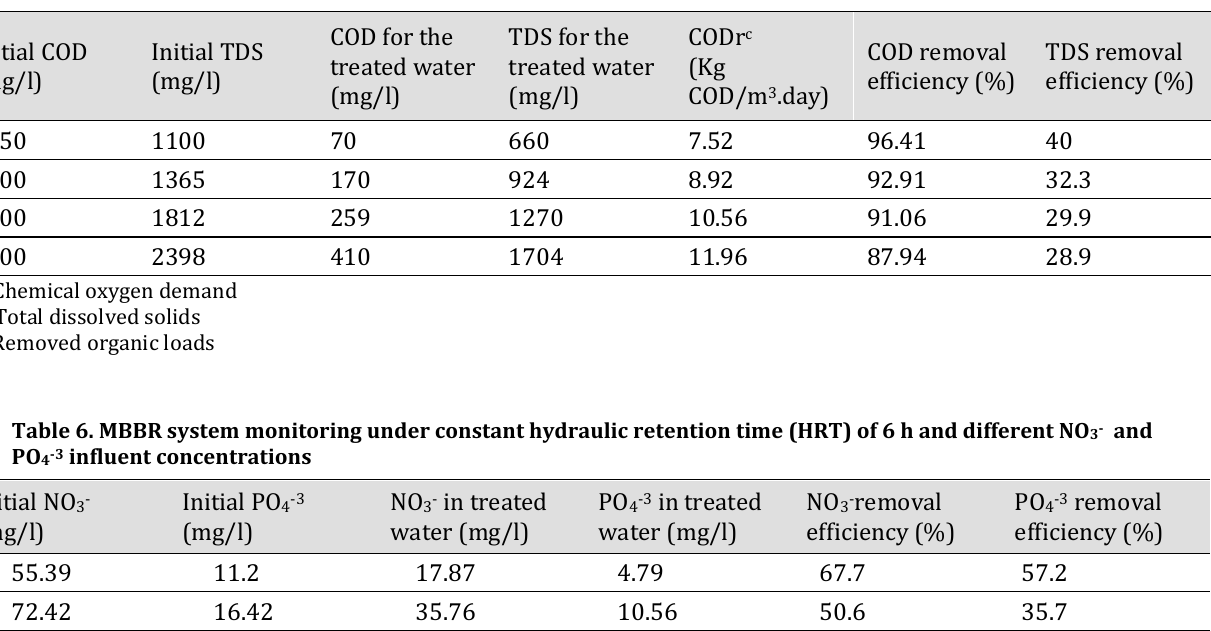
Table 5. MBBR system monitoring under constant hydraulic retention time (HRT) of 6 h and different COD a and TDS b influent concentrations